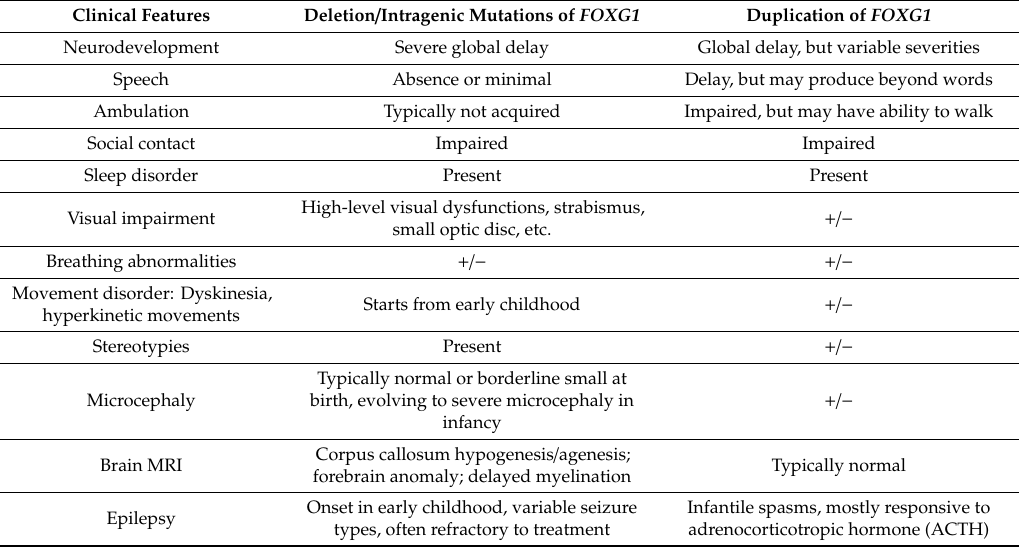
Table 1. The clinical characteristics of patients with FOXG1 deletion / intragenic mutations and FOXG1